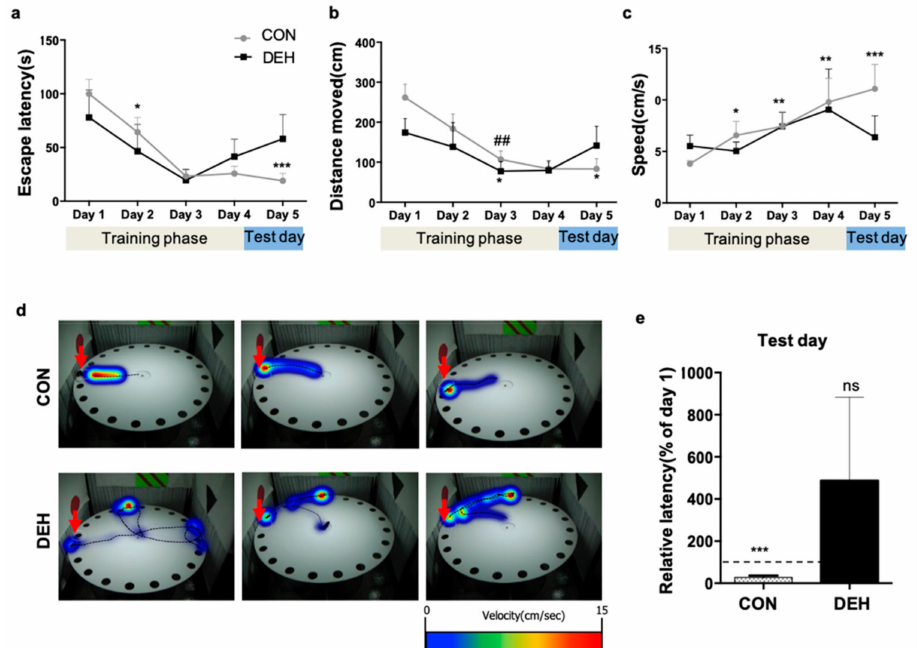
Figure 1. Dehydration markedly alters spatial learning behavior in young mice. Spatial learning behavior was measured in control (CON) and dehydrated (DEH) mice by using the Barnes maze test to measure the ( a ) primary escape latency, ( b ) total distance moved, and ( c ) speed (calculated by dividing total distance moved by the primary latency) during the 4-day maze ‘training’ phase. ( d ) Representative heatmap images (i.e., heatmap indicates time spent at each position) tracking the path taken by mice through the maze on the final ‘test’ day. Arrow, target escape hole. ( e ) The average relative latency (%) required to identify the escape hole on the test day was calculated by dividing the escape latency (s) achieved on the test day by that achieved on the first day. Data are presented as the mean ± SEM. Statistical significance was evaluated using a Student’s t -test: * p < 0.05, ** p < 0.005, *** p < 0.001 versus day 1 in the DEH group; ## p < 0.01 versus day 1 in the CON group. NS, not statistically